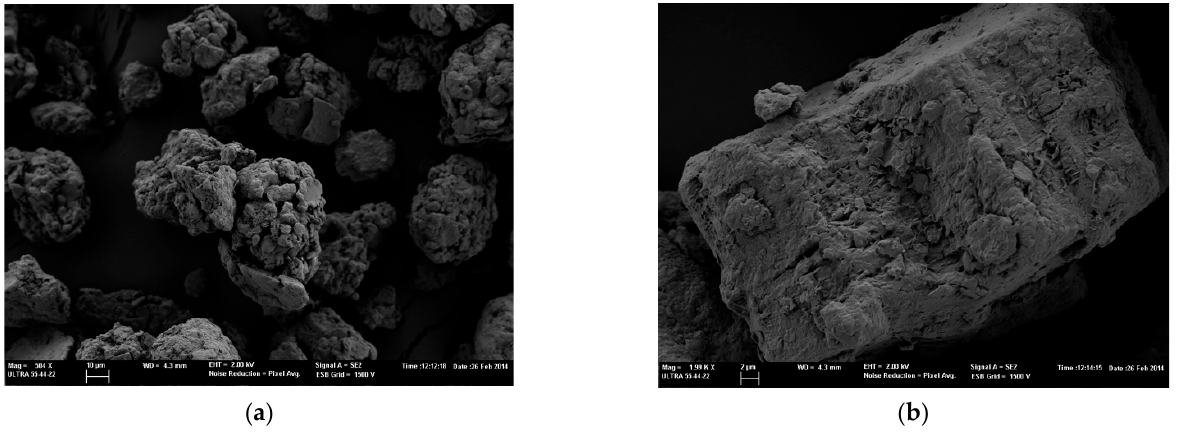
Figure 1. FESEM images of MMT KSF microparticles. ( a ) At 500× magnification and ( b ) at 2000× Figure 1. FESEMimagesofMMTKSFmicroparticles. ( a )At500 × magnificationand( b )at2000 × magnification.